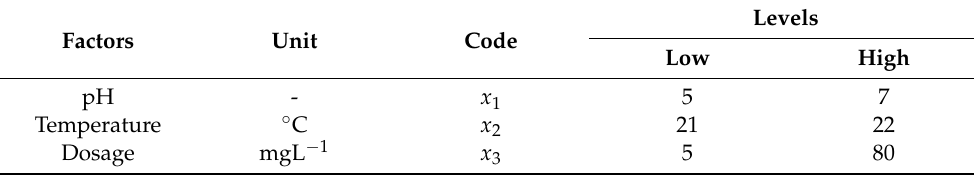
Table 2. List of independent variables and their